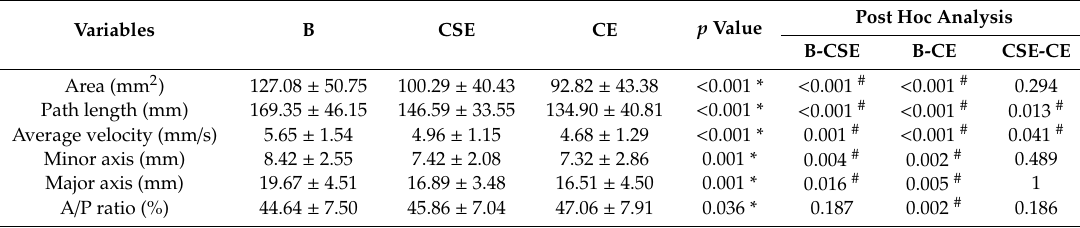
Table 2. Comparison of static balance ability in the eye-opened condition.